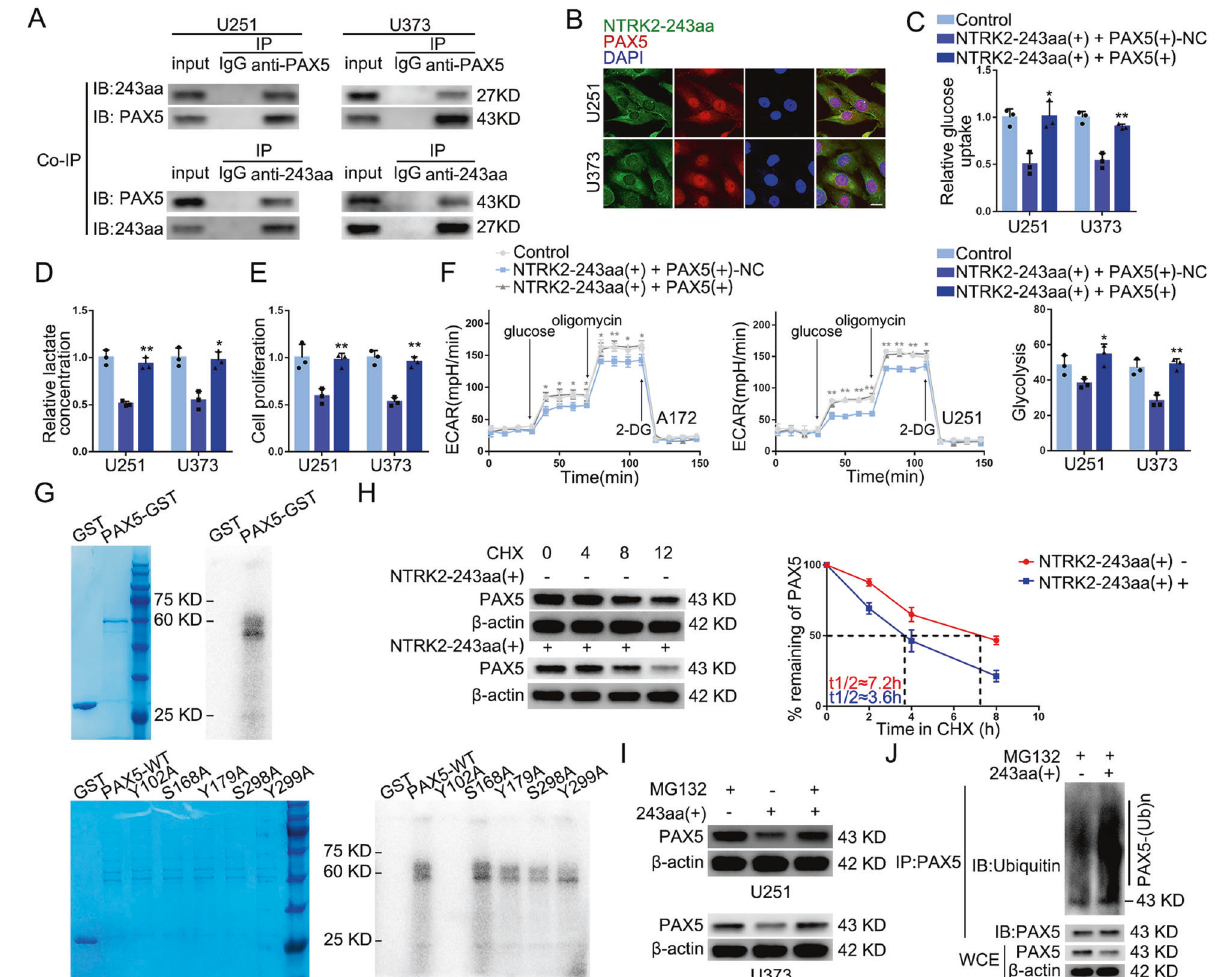
Fig. 6 NTRK2-243aa attenuated the Half-life of PAX5 Protein via phosphorylating PAX5 to regulate Glycolysis and Proliferation of GBM Cells. A The interaction of NTRK2-243aa and PAX5 in the cytoplasmic proteins of U251 and U373 was determined by co-IP assays. B Colocalization of NTRK2-243aa and PAX5 in U251 and U373 cells was determined by IF staining and observed by laser scanning confocal microscopy (NTRK2-243aa was labeled in green by secondary antibody against anti-NTRK2-243aa antibody. PAX5 antibody was labeled in red by secondary antibody against anti-PAX5 antibody and nuclei were labeled in blue by DAPI. Scale bar represents 10 µm). C – E The reverse effects of PAX5 on NTRK2-243aa in terms of glucose uptake, lactate production, and proliferation in U251 and U373 cells. Data are presented as mean ± SD ( n = 3, each group). * P < 0.05, ** P < 0.01, compared with NTRK2-243aa( + ) + PAX5( + )-NC group. F The reverse effects of PAX5 on ECAR in U251 and U373 cells were tested and glycolysis levels in each ECAR group were analyzed. Data are presented as mean ± SD ( n =